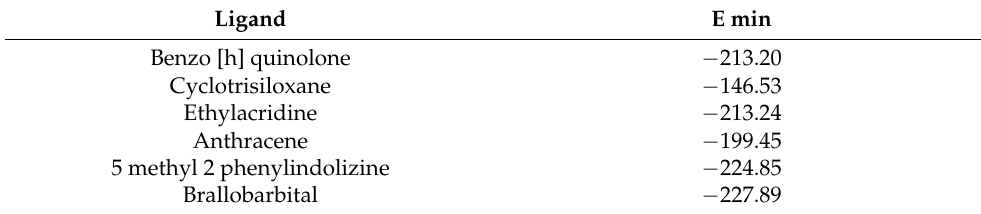
Table 10. E-value scoring pattern of EGFR Receptor and endophytic fungal metabolites (Ligands) obtained through molecular docking